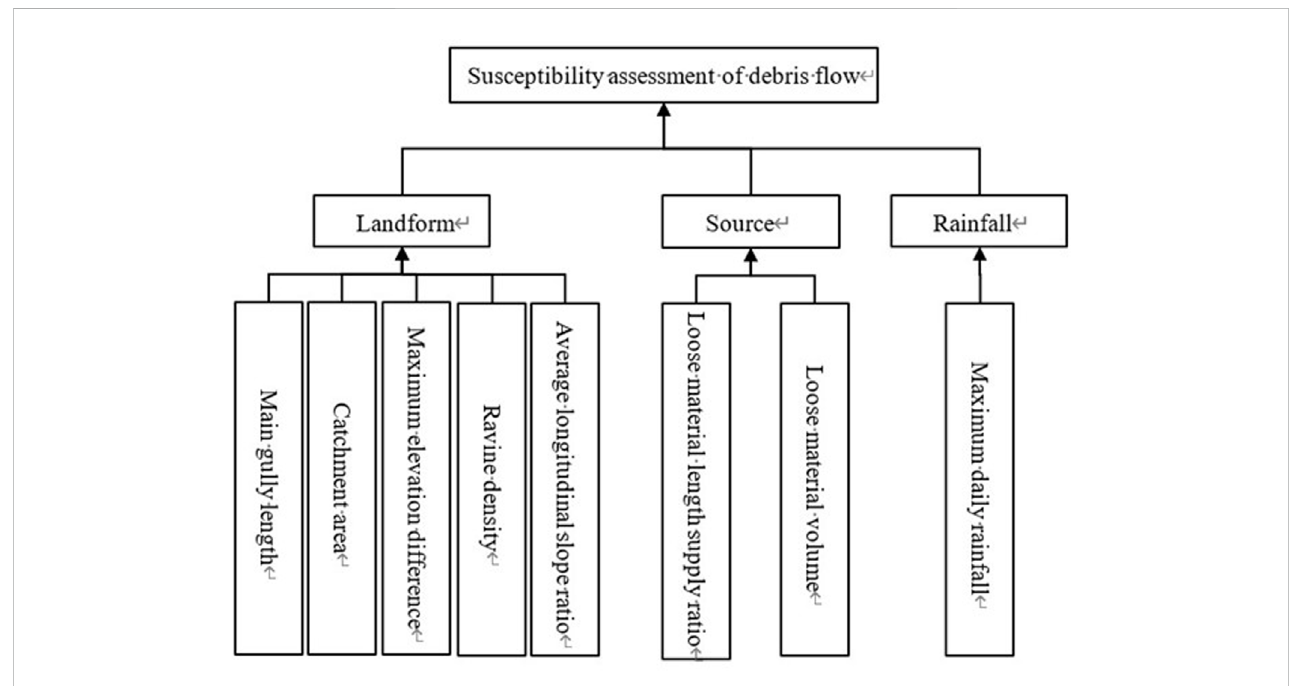
FIGURE 3 AHP model for susceptibility assessment of potential debris fl ow in Shaling Gully.